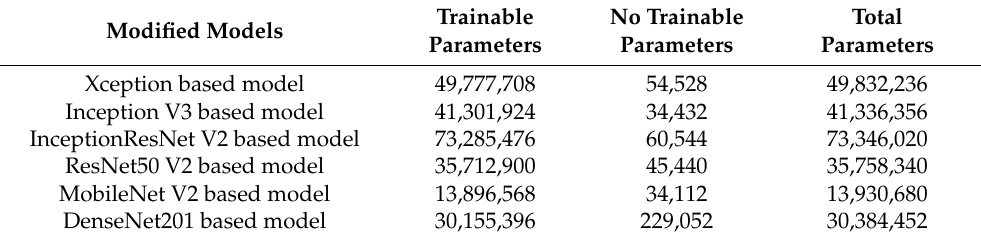
Table 10. The proposed modified-based DenseNet201 model